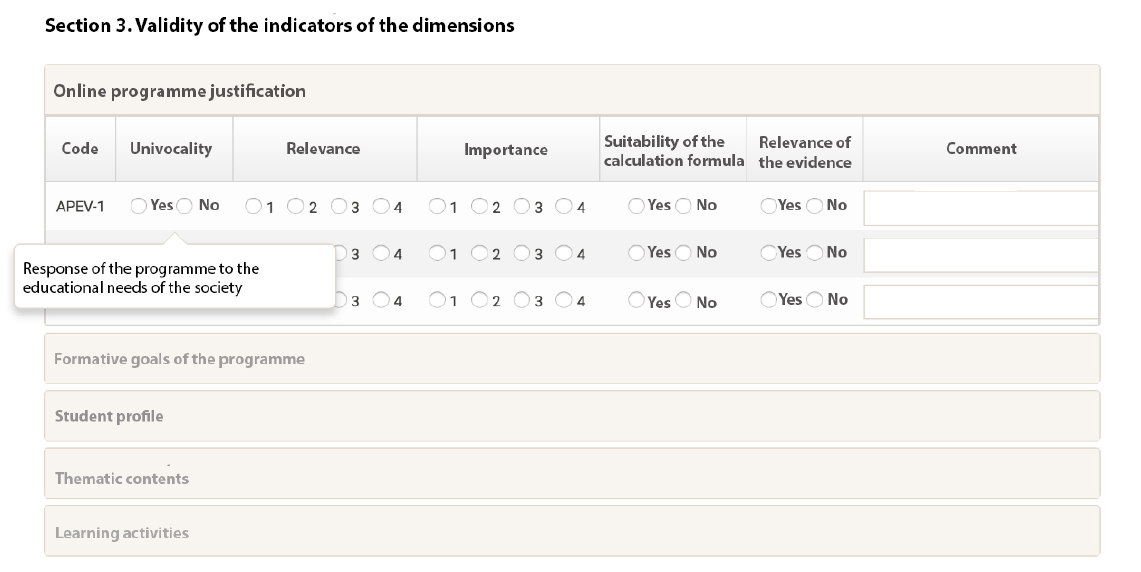
Figure 3. A screenshot of the online validation form (section